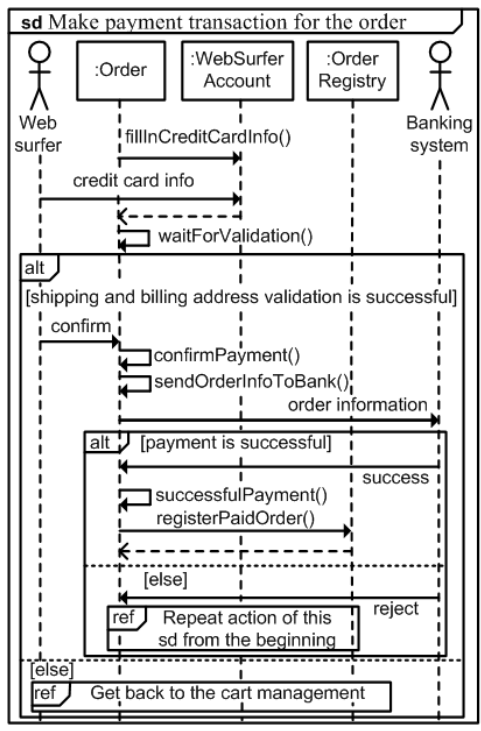
Fig. 7. Sequence diagram of making a payment transaction for the order, obtained by applying